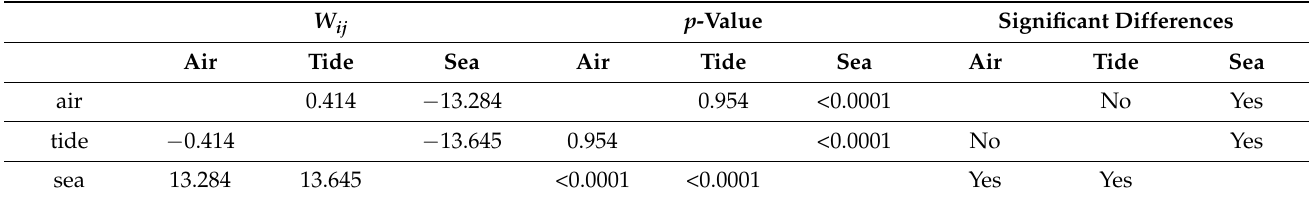
Table 15. Two-tailed Steel-Dwass-Critchlow-Fligner test details for the NiTi-1 alloy. W ij p -Value Significant